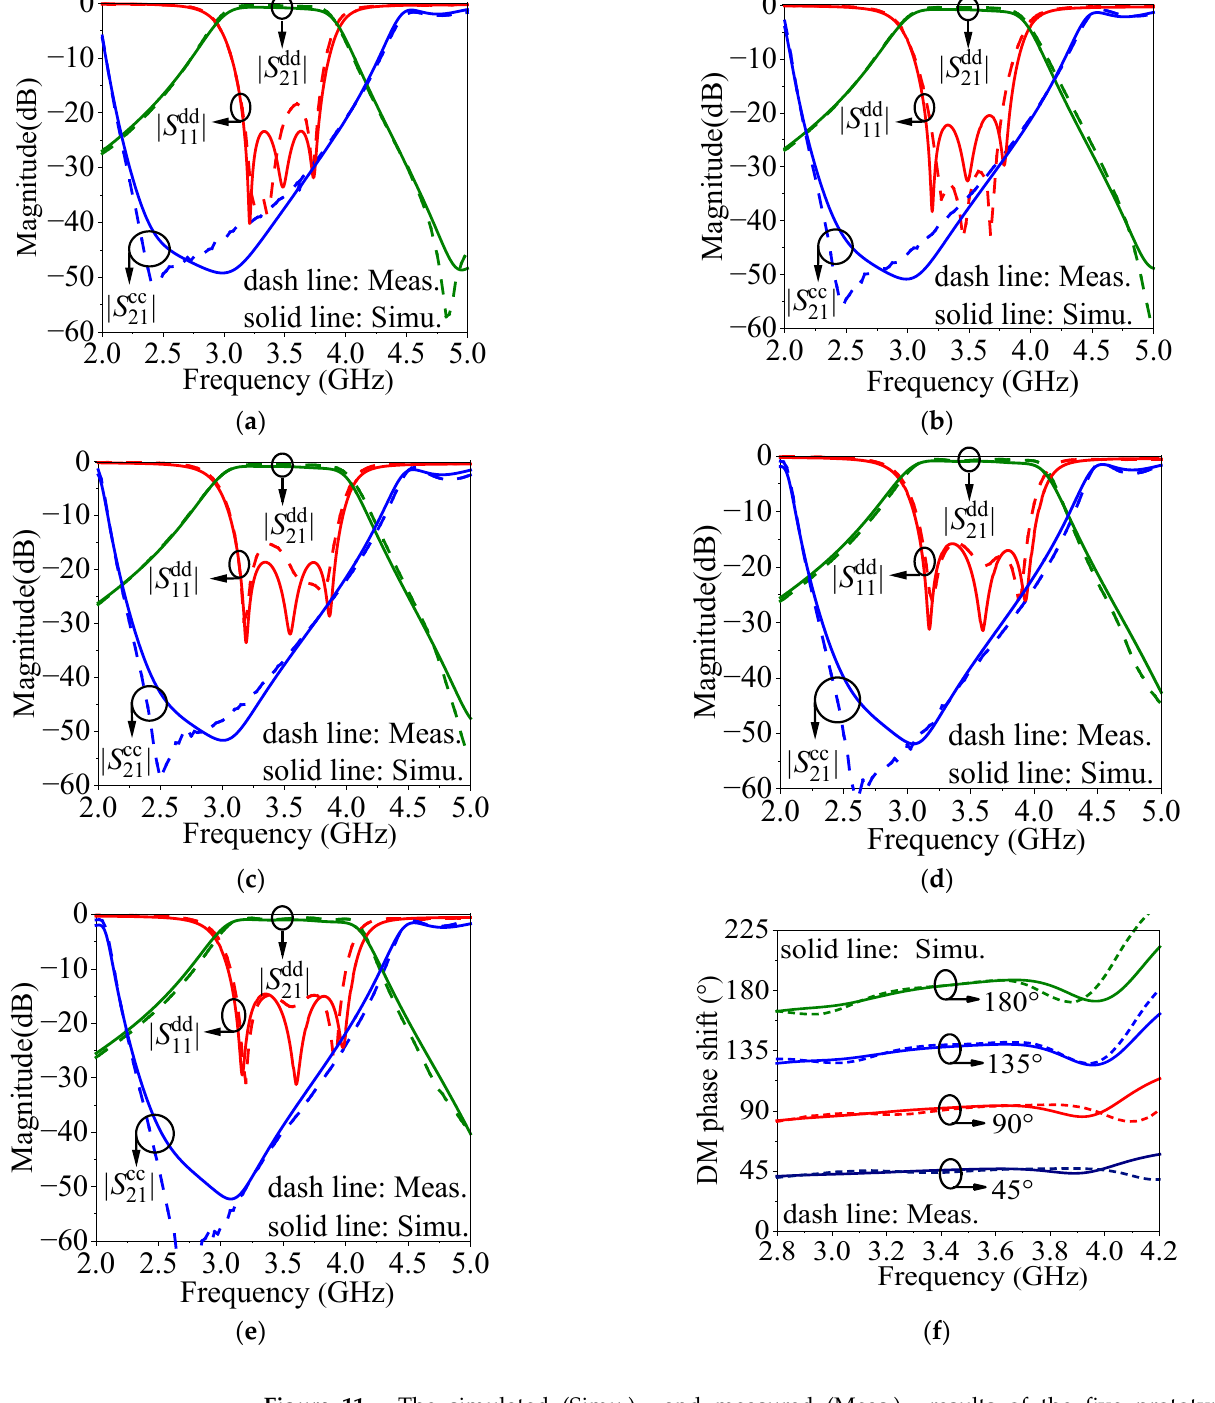
Figure 11. The simulated (Simu.) and measured (Meas.) results of the five